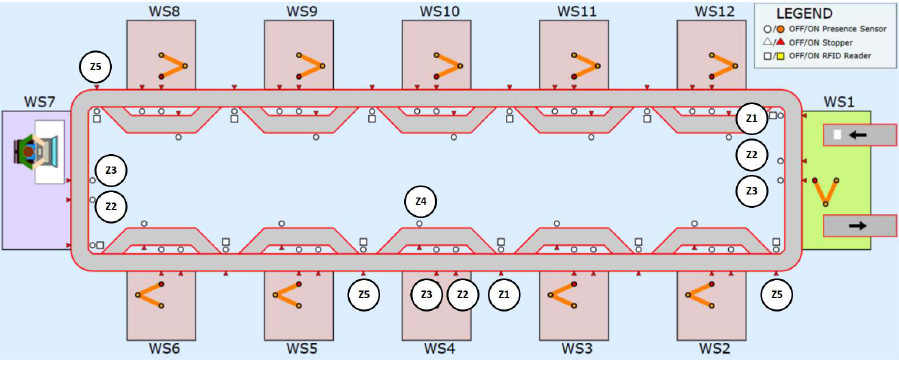
Figure 4. FASTory line layout [27].